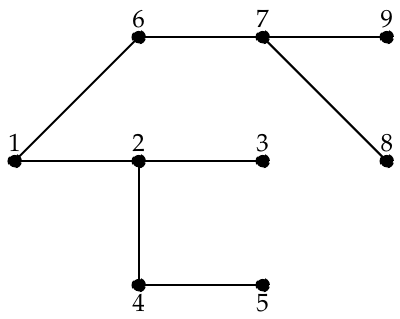
Figure 2. Possible routes of the distribution test